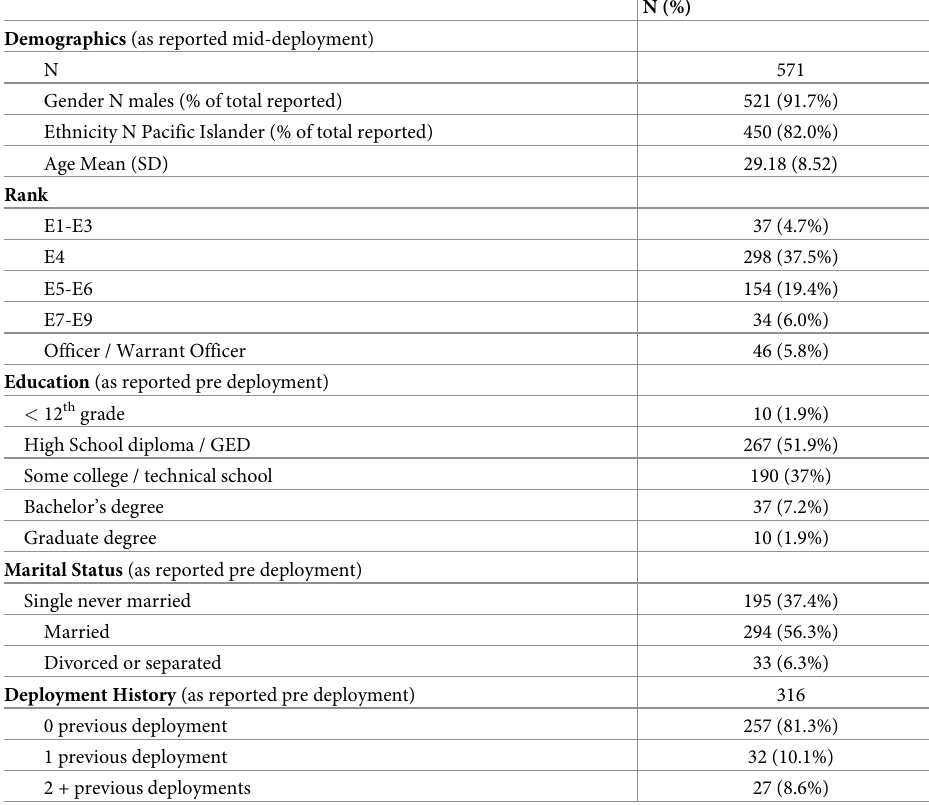
Table 1. Demographic characteristics of the